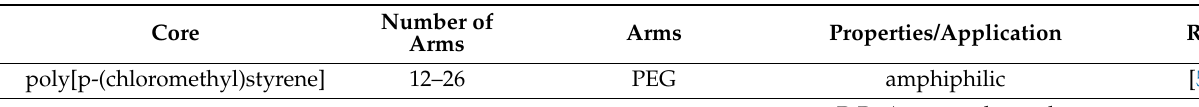
Table 2. Star (co)polymers obtained in the Laboratory of Nano- and Microstructural Materials. Number of Core Arms Properties/Application Arms PtBuAc stars: thermal properties PAA stars: amphiphilic/formation